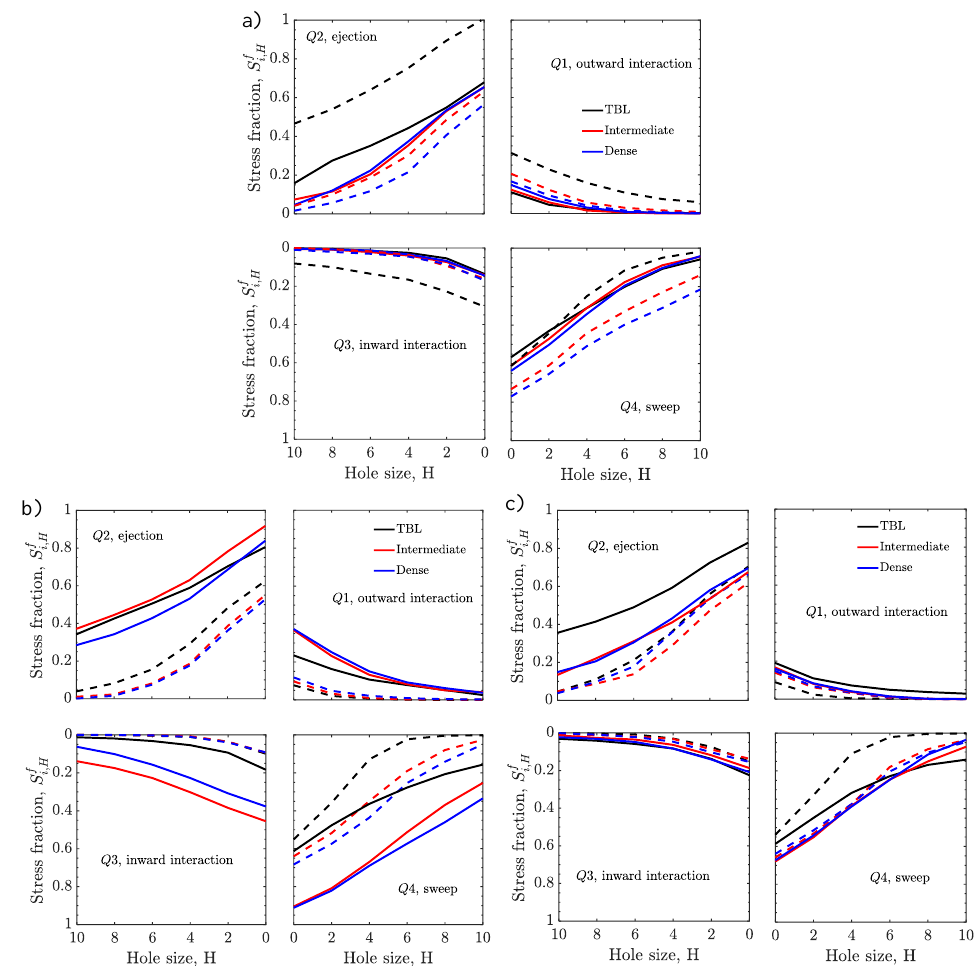
Figure 8. Kinematic shear stress fractions S f versus hole size, H , at z / z hub ≈ 0.11 (solid lines) and i , H z / z hub = 1.6 (dashed lines) above the forest canopies at ( a ) incoming boundary layer, ( b ) x / d T = 3 and ( c ) x / d T =